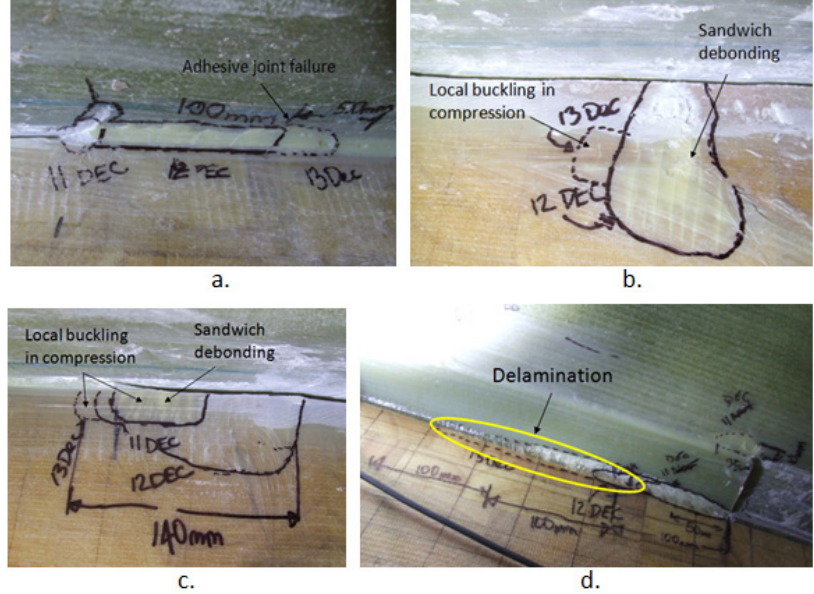
Figure 17. Crack propagation within the web; ( a ) adhesive joint failure outside the web; ( b , c ) local buckling under compression outside the web; ( d ) delamination inside the web.